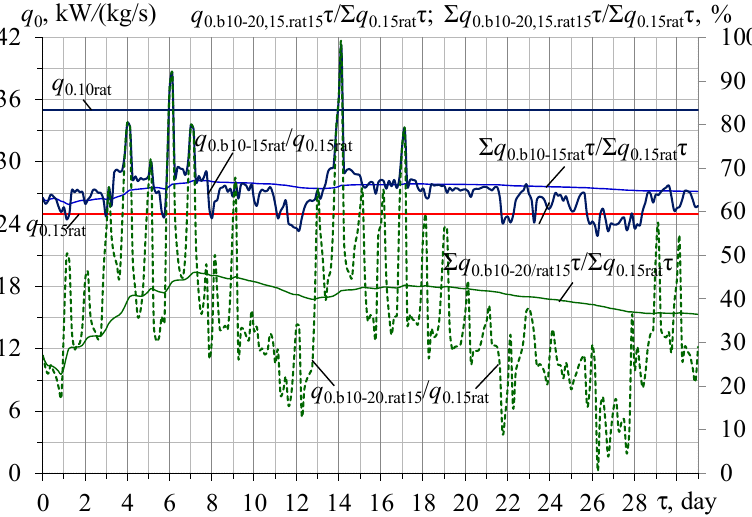
Figure 12. Actual relative reduced booster refrigeration capacities q 0.b10-15rat / q 0.15rat and q 0.b10-20.rat15 / q 0.15rat available for conditioning air to 10 ◦ C at threshold temperatures of t thr = 15 ◦ C and 20 ◦ C and corresponding reduced summarized refrigeration energy ∑ ( q 0.b10-15rat τ )/ ∑ ( q 0.15rat τ ) and ∑ ( q 0.b10-20.rat15 τ )/ ∑ ( q 0.15rat τ ), generated according to reduced design refrigeration capacity q 0.10red = q 0.15rat